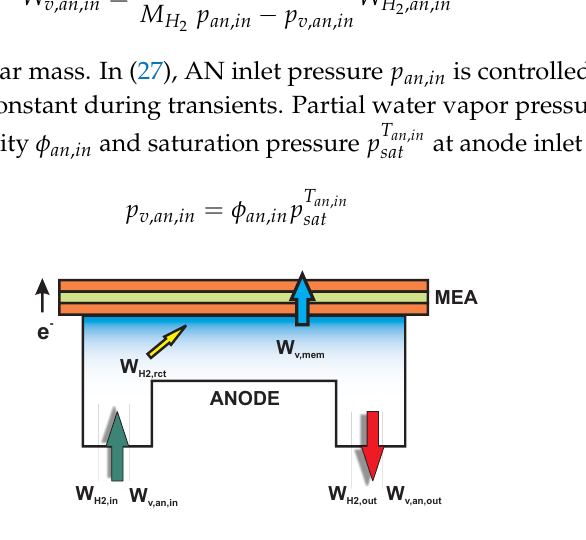
Figure 7. Mass flows modeled in